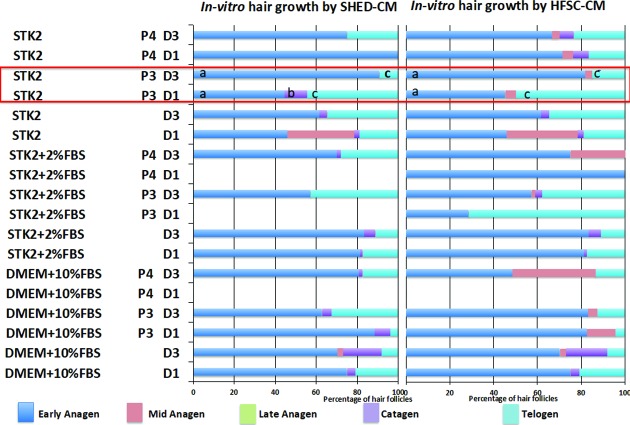
Percentage of hair follicles at each hair growth stage on day 1 and day 3, post CM treatment under in vitro conditions.The percentage of hair follicles transferred from the telogen-stage to the subsequent stages of hair growth following the CM treatment. *The same alphabet indicates a significant difference (p<0.05) aa-Significant increase in anagen stage bb-Significant decrease in catagen stage cc-significant decrease in telogen stage D = Day P = Passage.